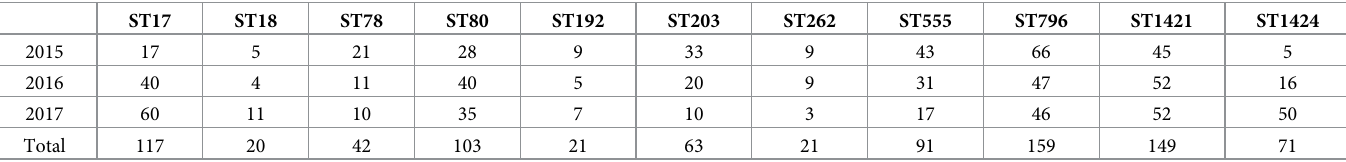
Table 1. Eleven major sequence types ( � 20 isolates) identified in the Australian Group on antimicrobial resistance Australian Enterococcal Sepsis Outcome Pro- gram